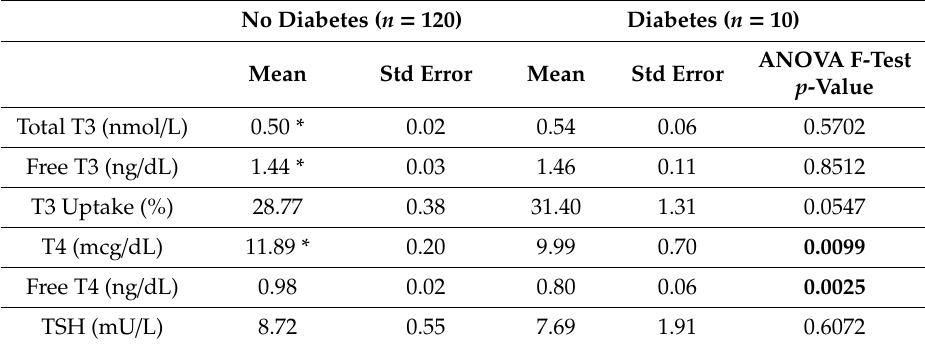
Table 7. E ff ect of diabetes on fetal thyroid